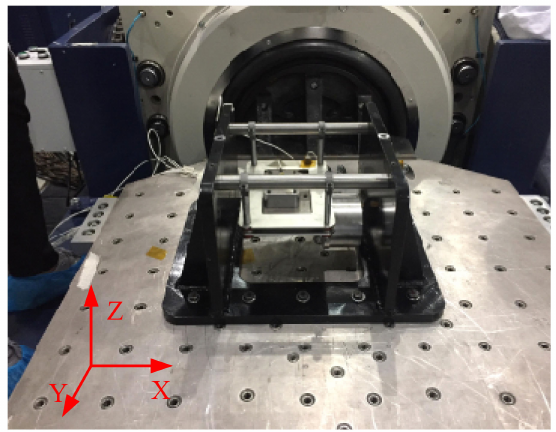
Figure 18. Vibration table vibration test control